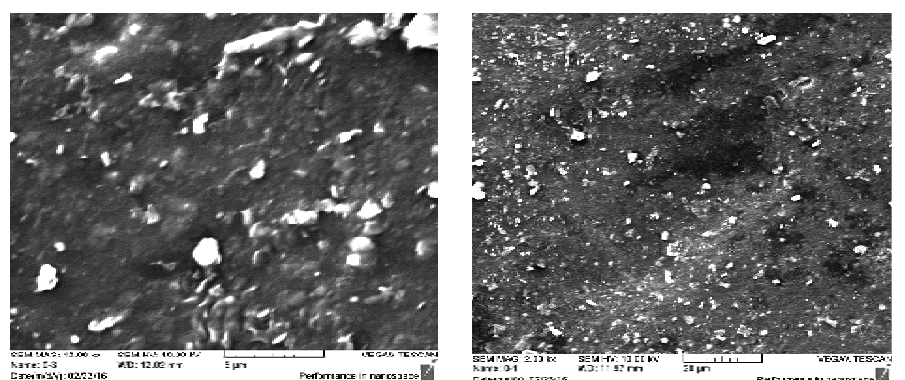
Fig. 1. SEM test for stock 2.